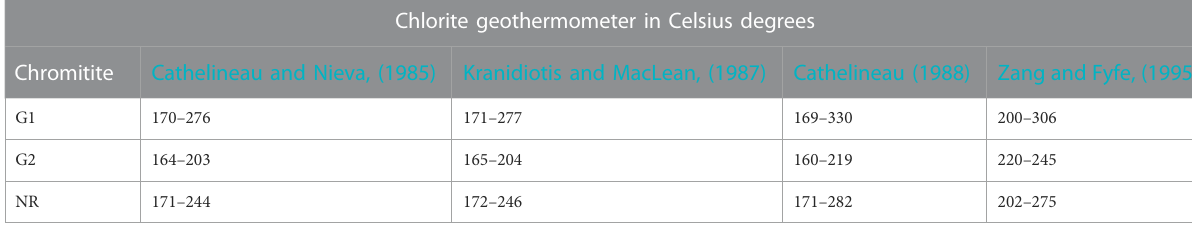
TABLE 1 Chlorite temperature calculations ( o C) based on four different